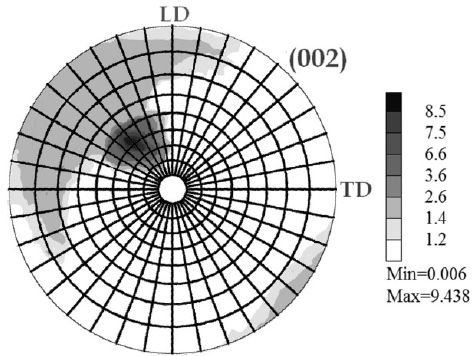
Figure 18. Pole figure of the (002) plane obtained after 2 passes mode B C .